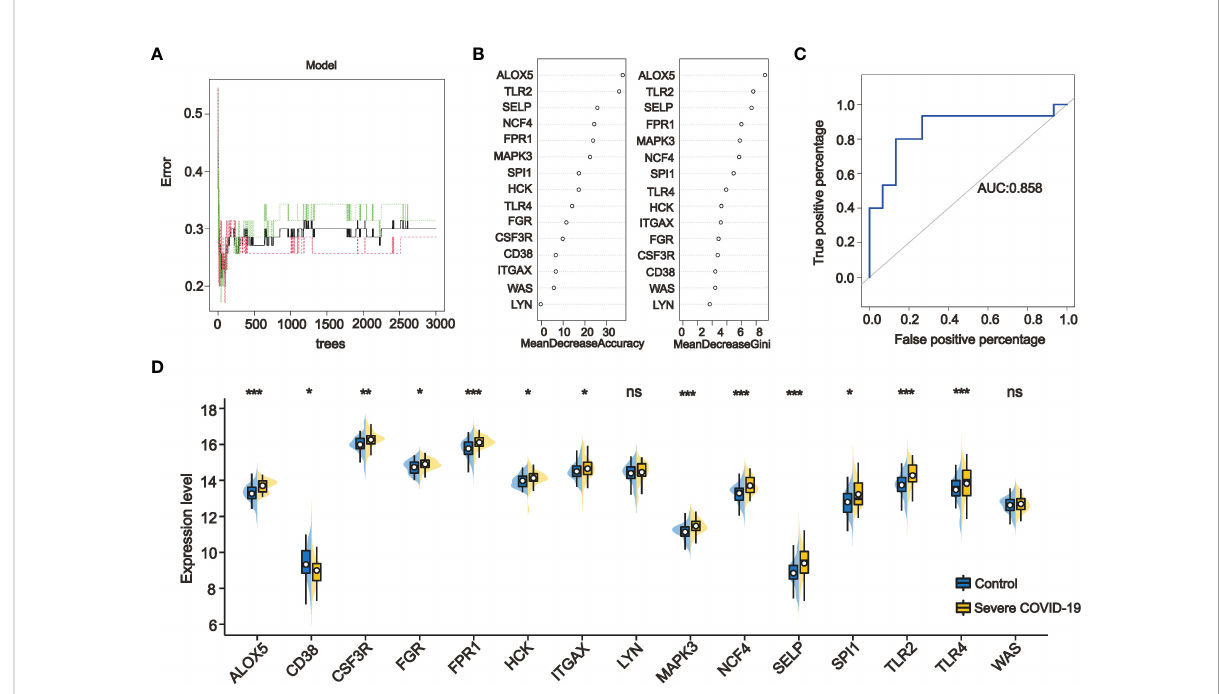
FIGURE 8 Ranking the importance of PPI-hub genes and validating their diagnostic ef fi cacy by random forest. (A) By iteratively optimizing the parameters, 3000 decision trees are ultimately selected to construct the random forest model. (B) The importance of the variables was ranked by mean decrease accuracy and mean decrease Gini, with higher values indicating that the variable contributes greater to the accuracy of the model. (C) The accuracy of the random forest model was validated in the test set, and the results showed that the model had a high accuracy (AUC: 0.858). (D) Validation the expression of PPI-hub genes in an independent COVID-19 dataset, most of the genes were signi fi cantly upregulated in patients with severe COVID-19 (*p < 0.05, **p < 0.01, ***p < 0.001, ns, not statistically signi fi